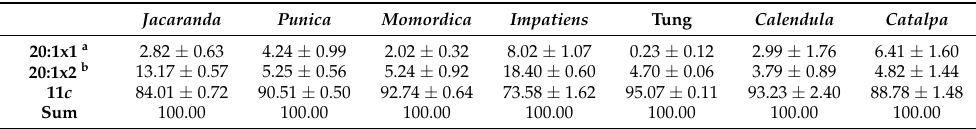
Table 7. 20:1 Isomer distributions. Entries are percentages of total integrated 20:1 FID signal and are the means of three independent determinations. Uncertainties are 95% confidence limits based on the t -distribution with 2 degrees of